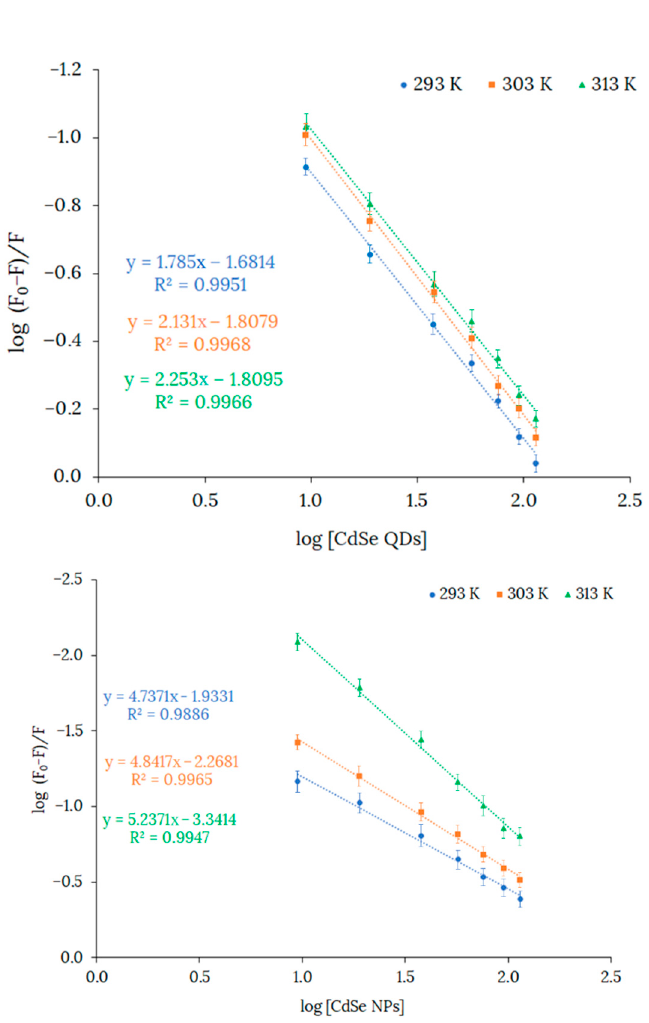
Figure 5. The Scatchard plot for binding H 3 L to CdSe NPs ( bottom ) and CdSe-Cys QDs ( top ) at 293, 303, and 313 K and pH 11.